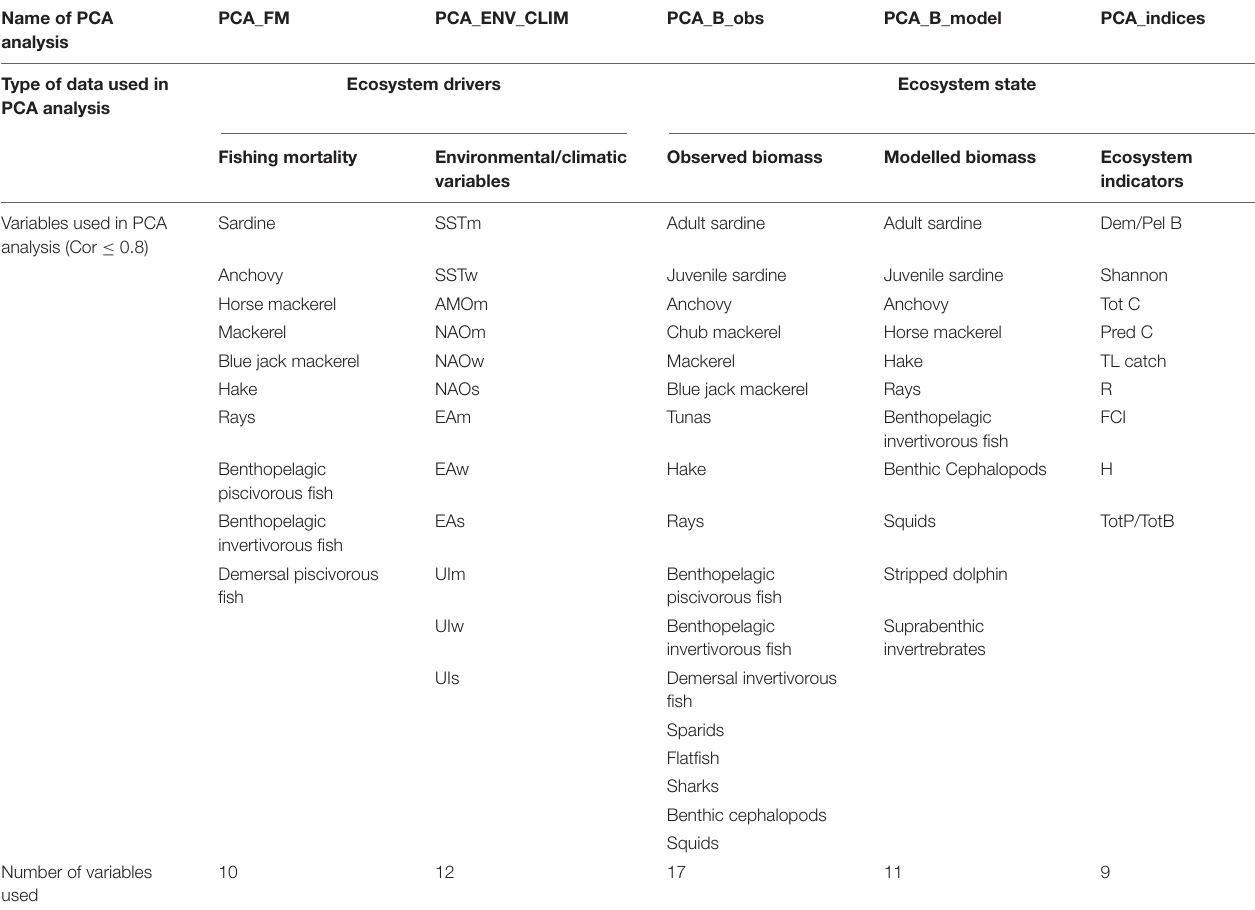
TABLE 3 | Variables used in principal component analysis (PCA) after selection process (criteria for selection: cross-correlation ≤ 0.8). Name of PCA